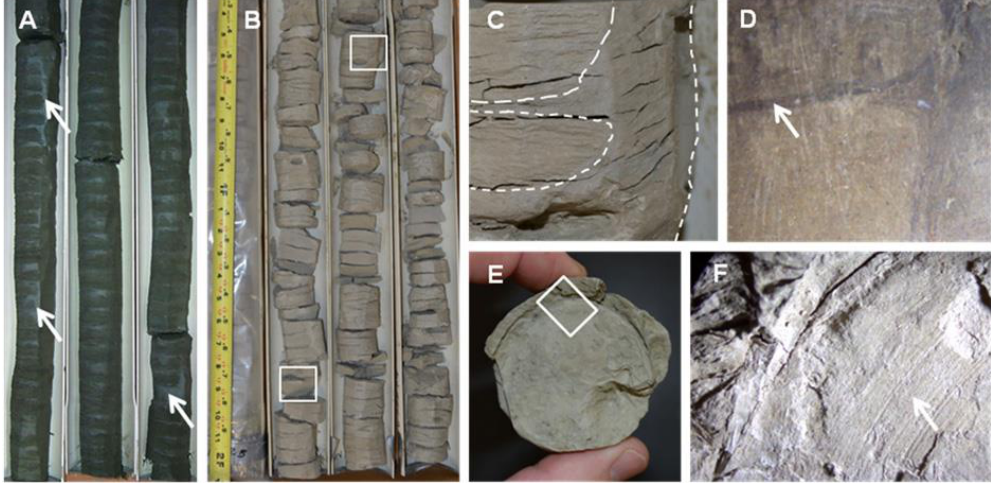
Figure 5. Evidence for drilling disturbance in the Millville core from the interval 890 to 910 feet subsurface (1 foot = 0.3048m). (a) Part of the core when freshly recovered (modified from Wright and Schaller, 2013, arrows added). The horizontal layers were described by Wright and Schaller (2013) as rhythmically bedded couplets, but were interpreted by Pearson and Nicholas (2014) as alternations of core discs and injected slurry. External drilling mud has been scraped off, but patches remain (as highlighted by arrows). Note that the thin internal partings are reflective like the external mud, and appear contiguous with it in places. (b) Part of the same core as viewed on 19 March 2014 after desiccation during nearly a decade of storage. Note that the core has fractured in many places along the slurry partings. (c) Detail of upper highlighted area in (b) , showing a thick layer of external drilling mud still attached to the right hand side. (d) Part of the same interval now cut in half-round and viewed under the microscope. The drilling slurry (darker color) forms a thin parting through the centre of the core (highlighted with arrow) which is contiguous with the external mud. The core discs appear eroded at their edges. (e) Top surface of the core disc from the lower highlighted area in (b) , showing an external coating of drilling mud around the upper half from the back of the core where it was not originally scraped off. (f) Microscopic detail of highlighted area in (e) showing the top surface of the core disc with concentric grooves, evidence of spinning in the core barrel. Similar observations were made at other levels in the